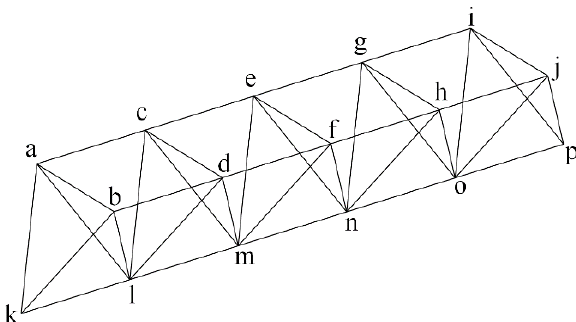
Figure 2. Layout of the Warren CHS tubular truss.